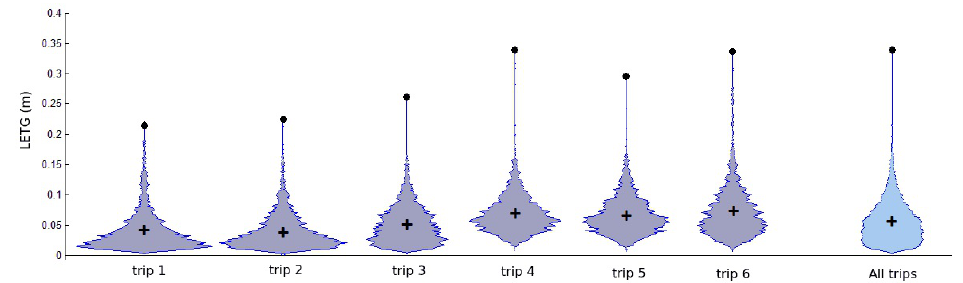
Figure 31. Violin plots (vertical histograms) of the absolute value of the lateral error of the target point (LETG). The crosses indicate the average error, and the dots indicate the maximum error for each